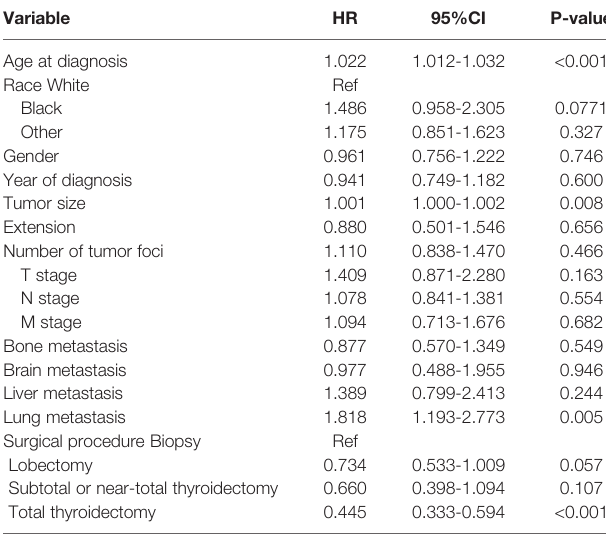
TABLE 1 | Demographics and clinical characteristics of 586 patients with anaplastic thyroid cancer. Variable